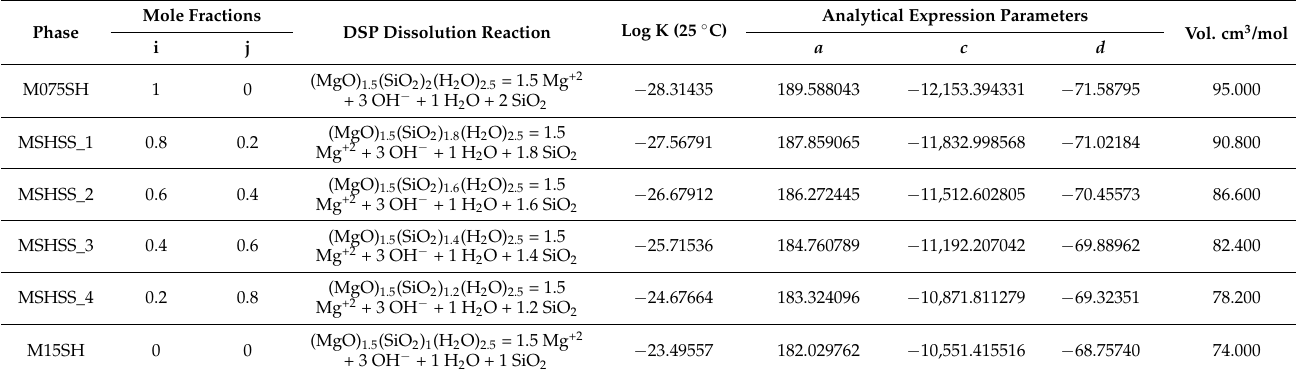
Table 5. End-members and DSP for the M-S-H